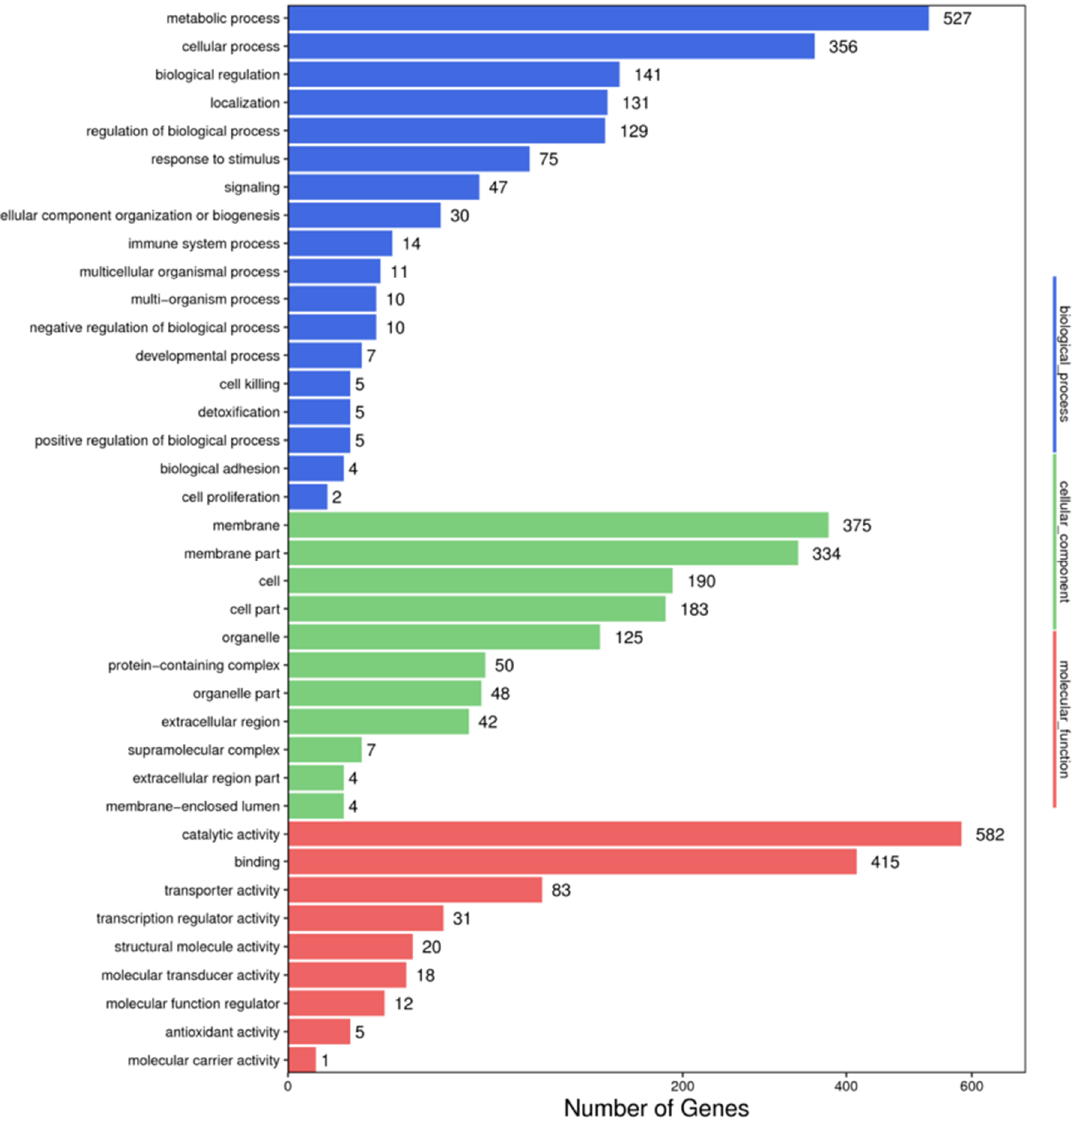
Figure 5. GO functional classification of DEGs from the 2766-KO knockout strain. X-axis indicates the number of DEGs. Y-axis represents GO terms.